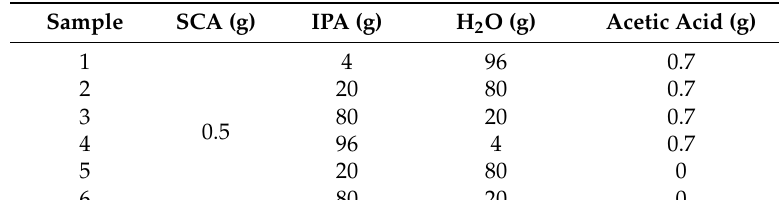
Table 2. The various conditions of hydrolysis reactions.